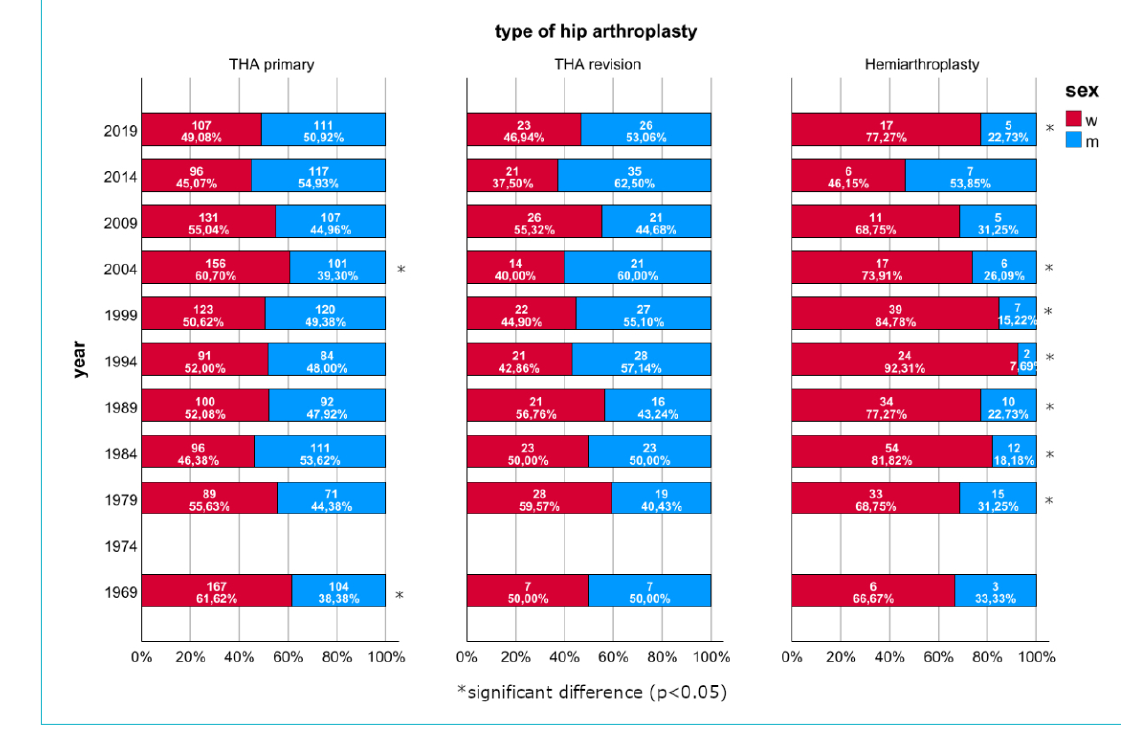
Figure 1: Number of operations divided by different types of hip arthroplasty and gender from 1969 to 2019 at 5-year